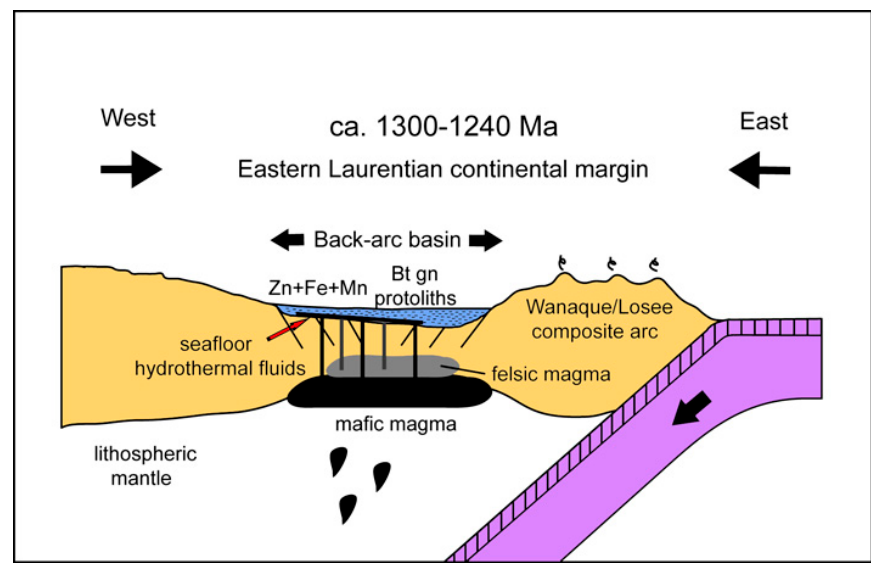
Figure 8. Tectonic setting of the New Jersey Highlands at ca. 1.3–1.24 Ga showing back-arc basin formed on extended crust inboard of the Wanaque/Losee continental margin arc [9]. Widespread hydrothermal activity driven by heat from shallow magma chambers beneath the back arc produced locally intense alteration in supracrustal metavolcanic rocks and precipitated Fe and Zn-Fe-Mn in carbonate protoliths on the seafloor. Metagraywacke and metapelite protoliths of biotite gneiss (Bt gn) hosting kornerupine + prismatine likely formed more distally from the influence of hydrothermal plumes. West and east refer to present coordinates.